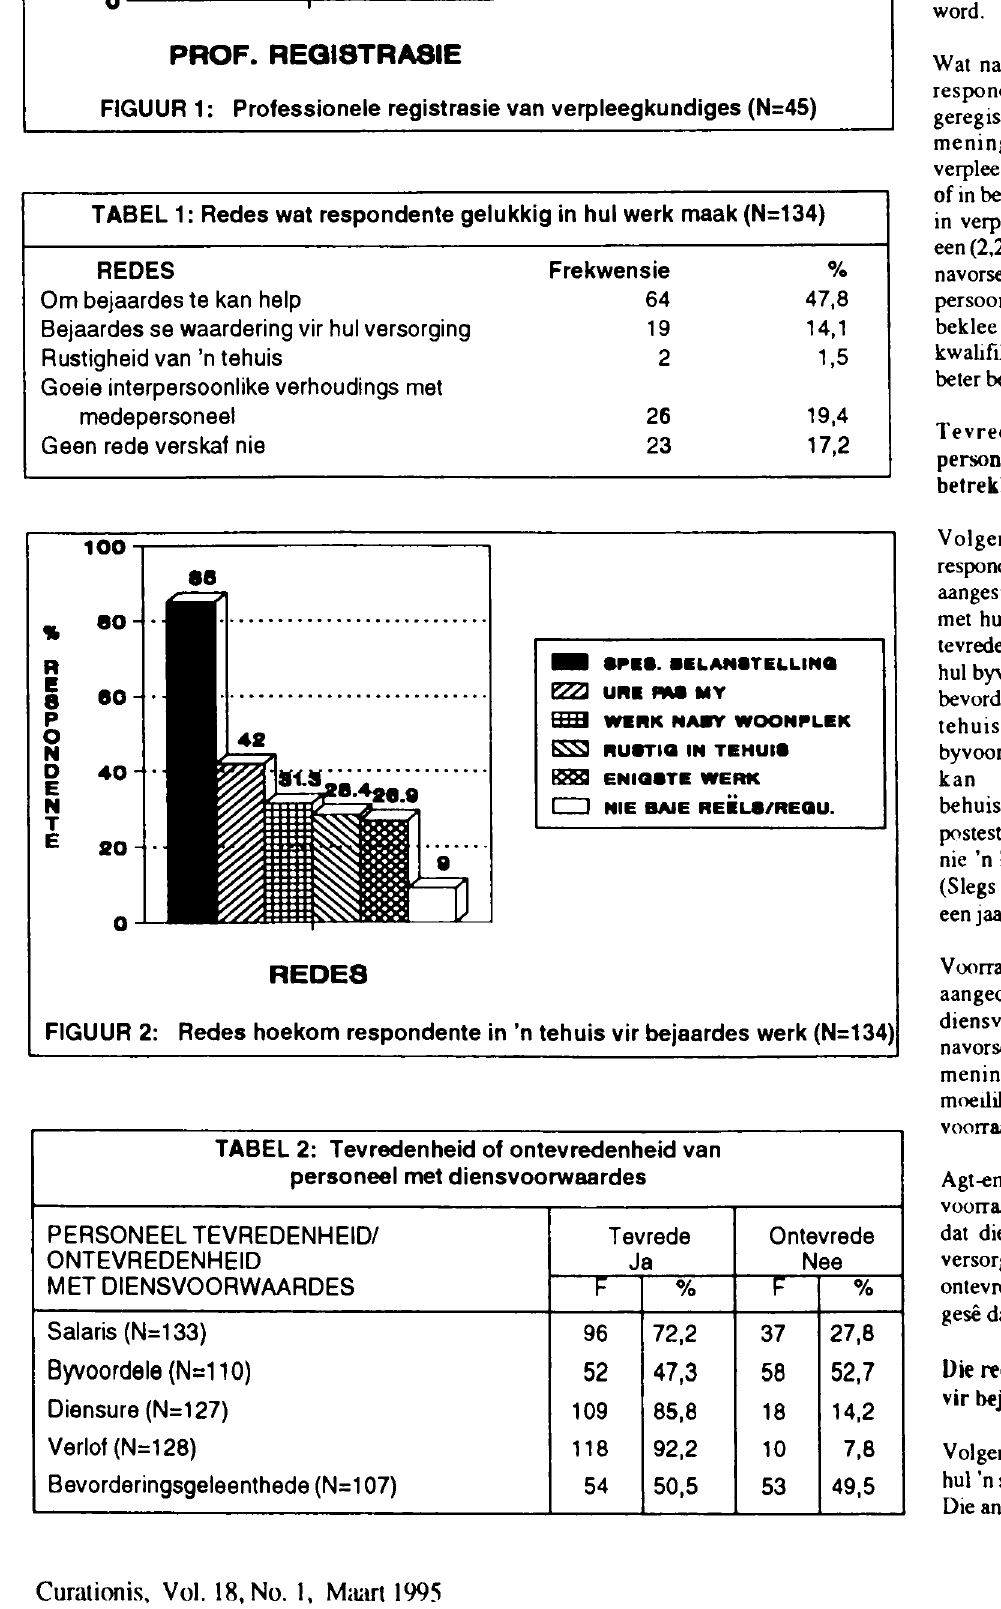
FIGUUR 1: Professionele registrasie van verpleegkundiges (N=45)